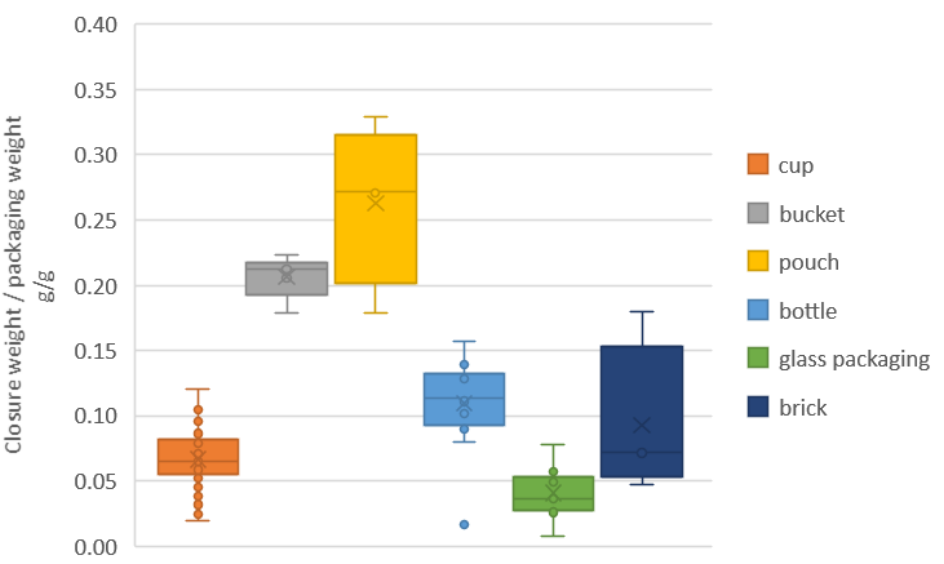
Figure 11. Ratio of closure weight to packaging weight (all parts including wrapper and shrink label if applicable) .